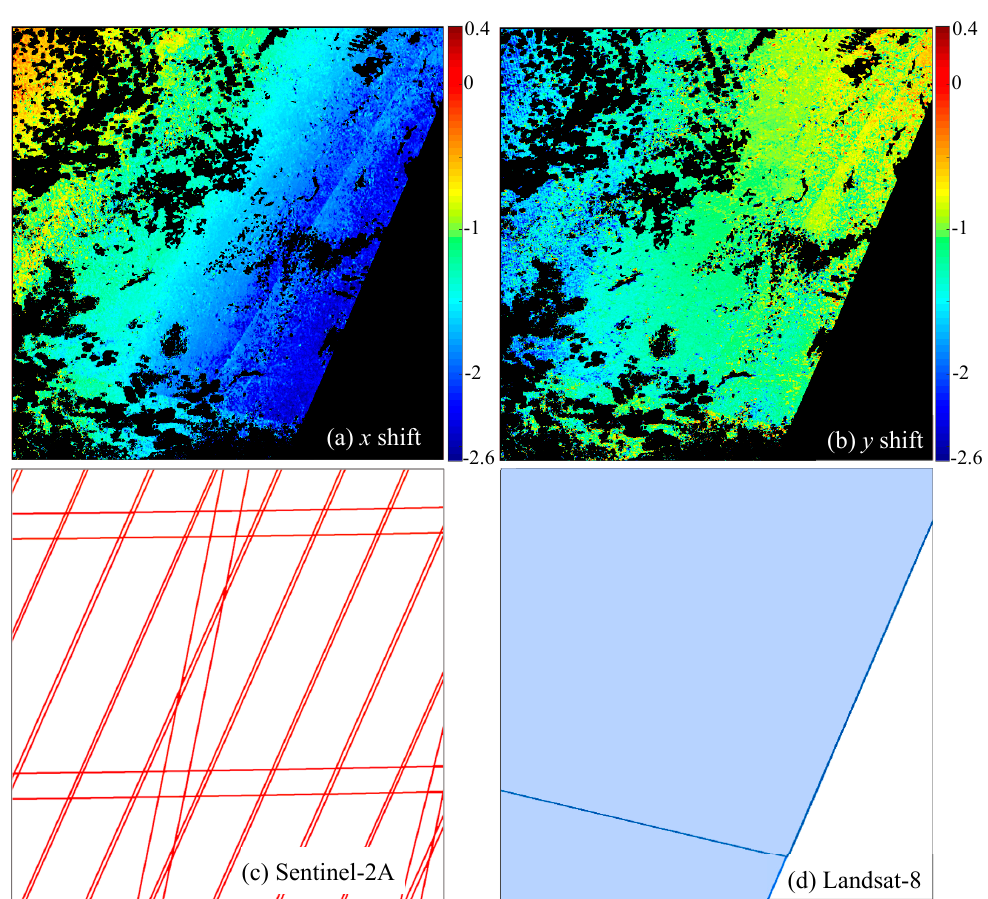
Figure 10. Dense-matching maps x and y axis shifts (units 10 m pixels) between the Limpopo Landsat-8 week 49 and Sentinel-2A week 49 image pair. The affine transformation was used to guide the dense matching (Section 4.4). The ( a ) x-shift x S , i ´ x L , i and ( b ) y-shift y L , i ´ y L , i are shown, where ( x S , i , y S , i ) is the Sentinel grid-point location and ( x L , i , y L , i ) is the corresponding least squares matched Landsat location for grid-point i . Locations where there are no matches are shown as black. Note that ( x L , i , y L , i ) is theoretically independent on the transformation type and so the translation and polynomial-based shift maps, which were very similar to the affine-based shift maps, are not shown; ( c ) shows the Sentinel-2A L1C tile and detector boundaries (red) and ( d ) shows the Landsat-8 L1T image boundaries (blue).